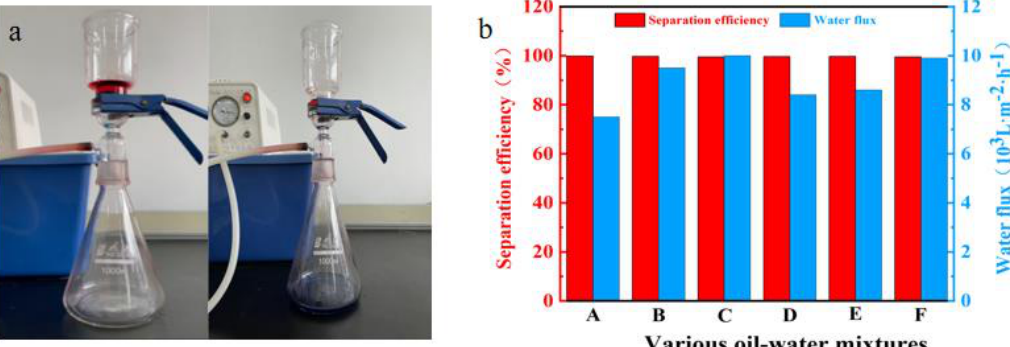
Figure 7. ( a ) Dynamic process of oil − water separation ( b ) Water flux and separation efficiency of six oil − water mixtures (A − F represent dichloroethane, petroleum ether, toluene, soybean oil, diesel, hexane and water mixtures, respectively).